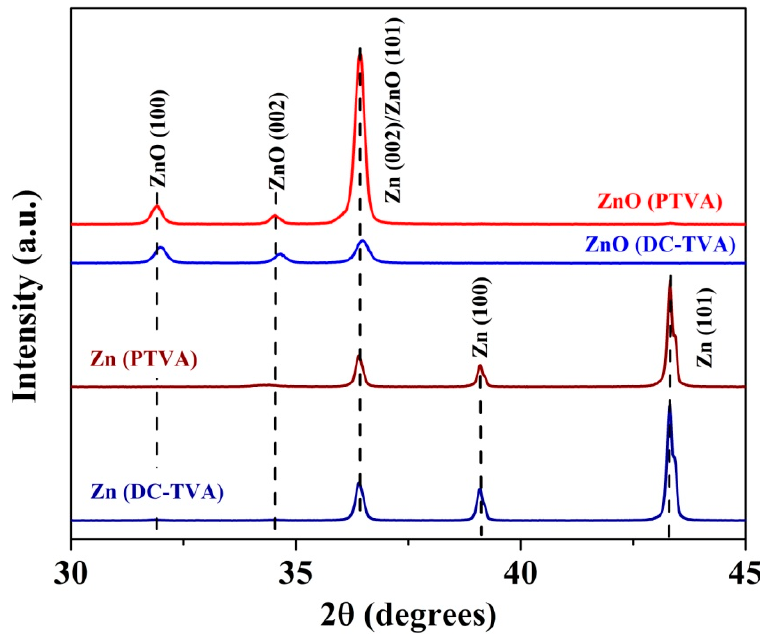
Figure 3. X-ray-diffraction patterns for as-deposited Zn coatings and thermal-annealed coating (ZnO) synthesized by DC-TVA and PTVA.